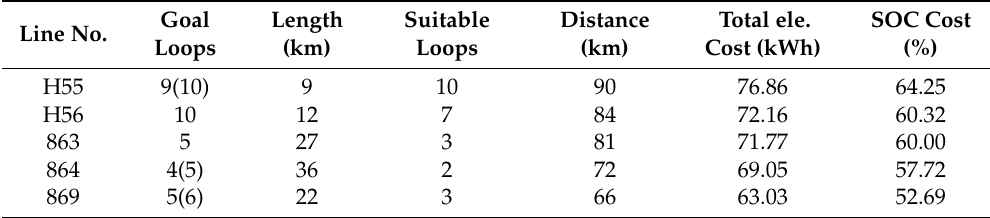
Table 6. Suitable loops for each line.